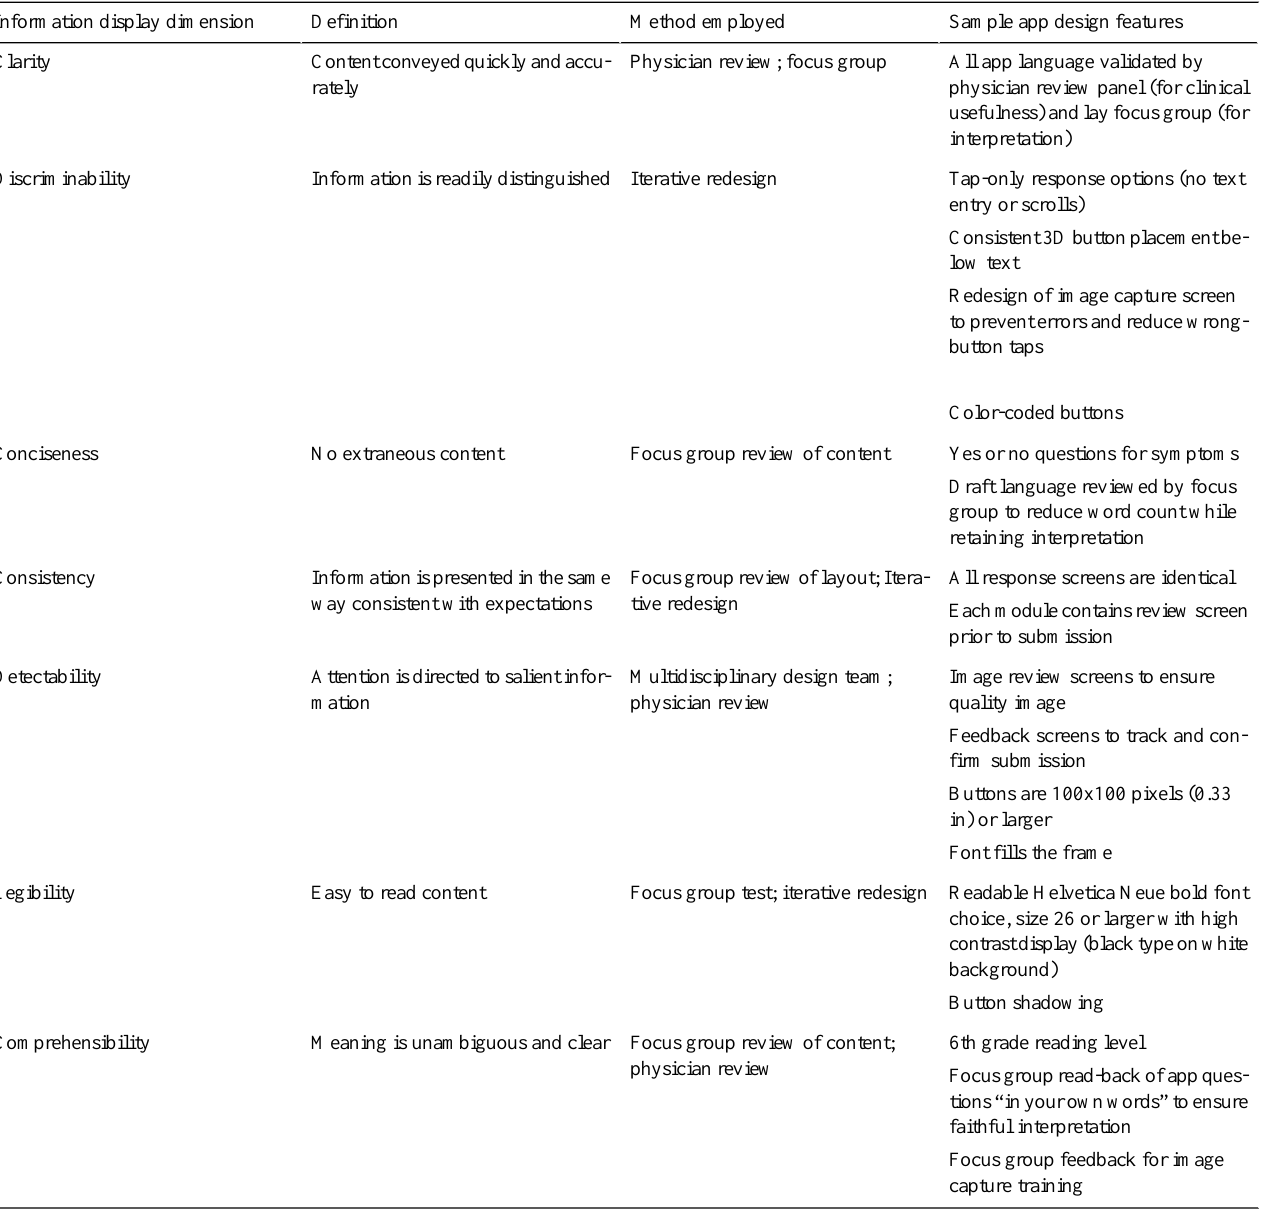
Table 1. User interface design dimensions from International Organization for Standardization (ISO) standard 9241-12 and corresponding WoundCheck design